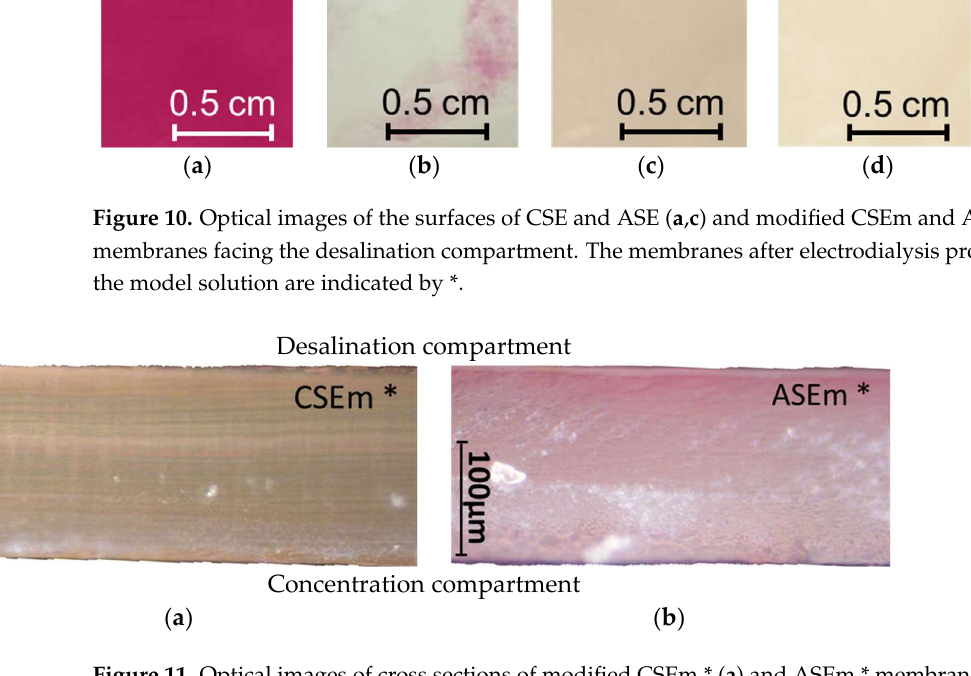
CSEm * surface remained more hydrophobic than in the case of the CSE * membrane (Ta-